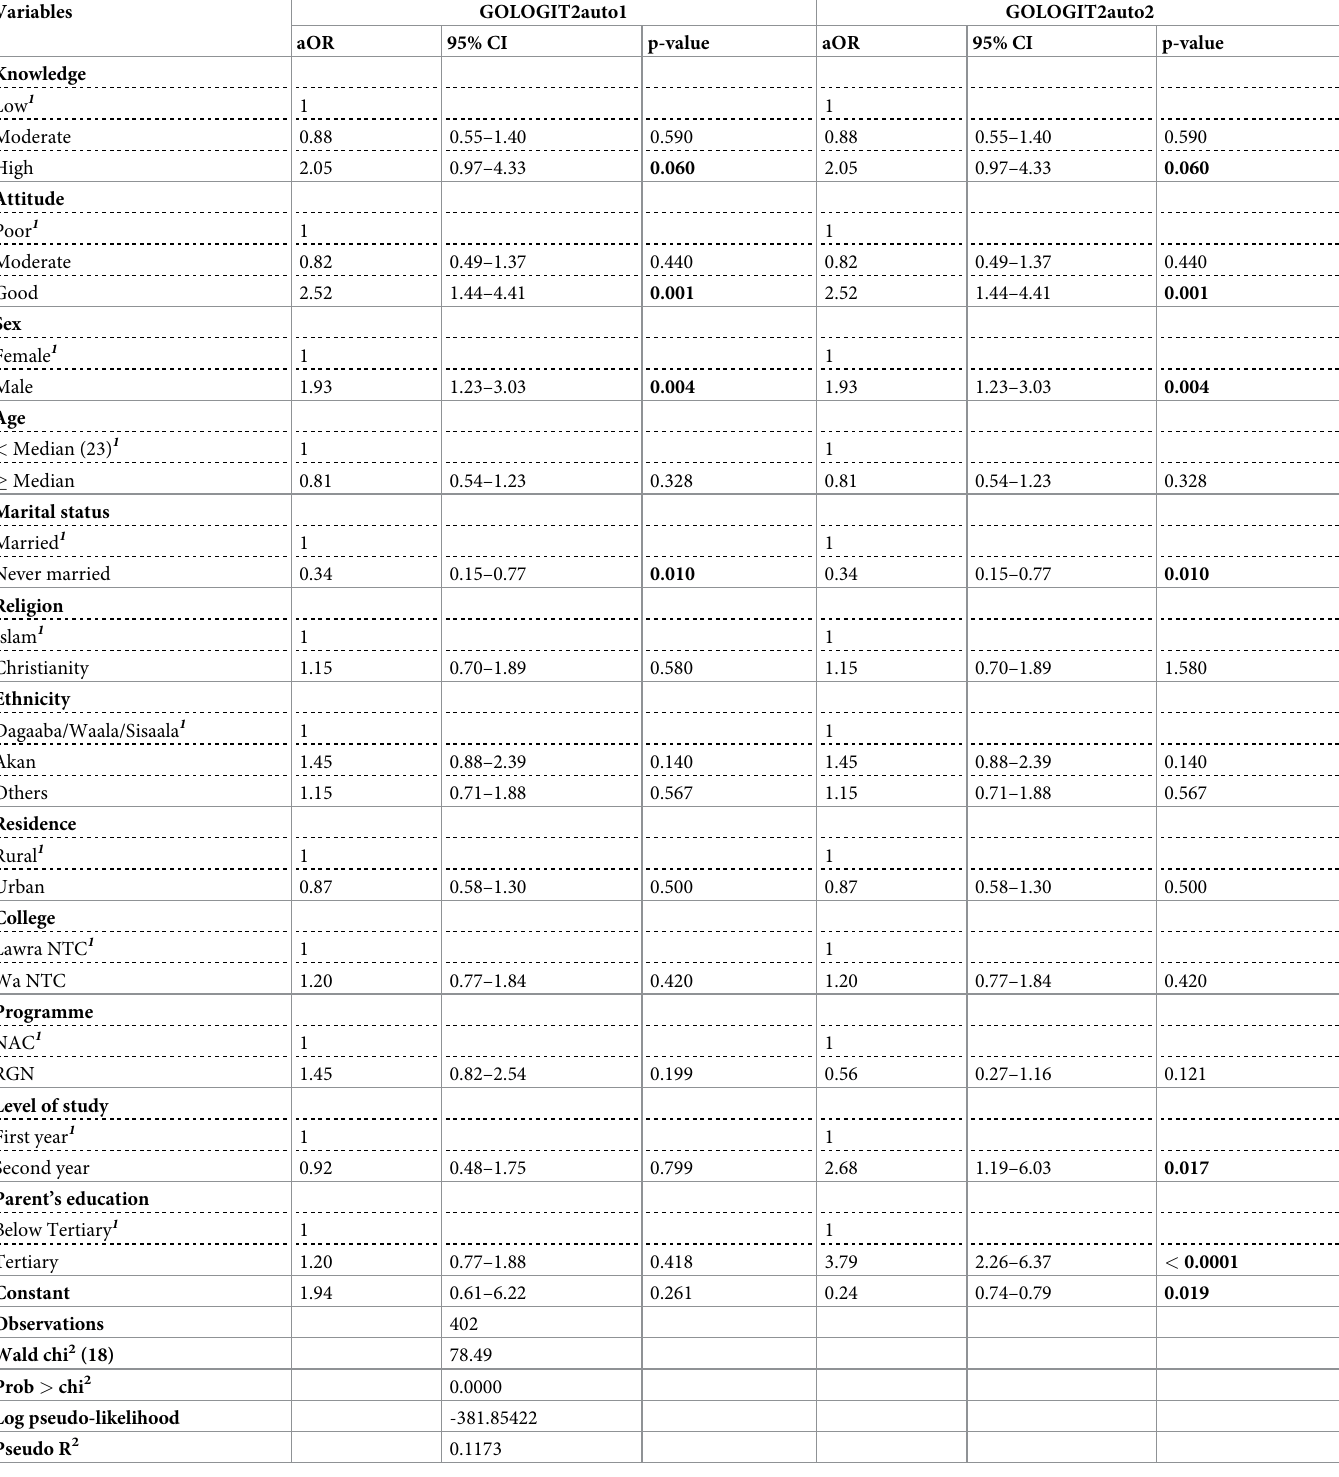
Table 6. Factors associated with the practice of hepatitis B infection prevention (n =